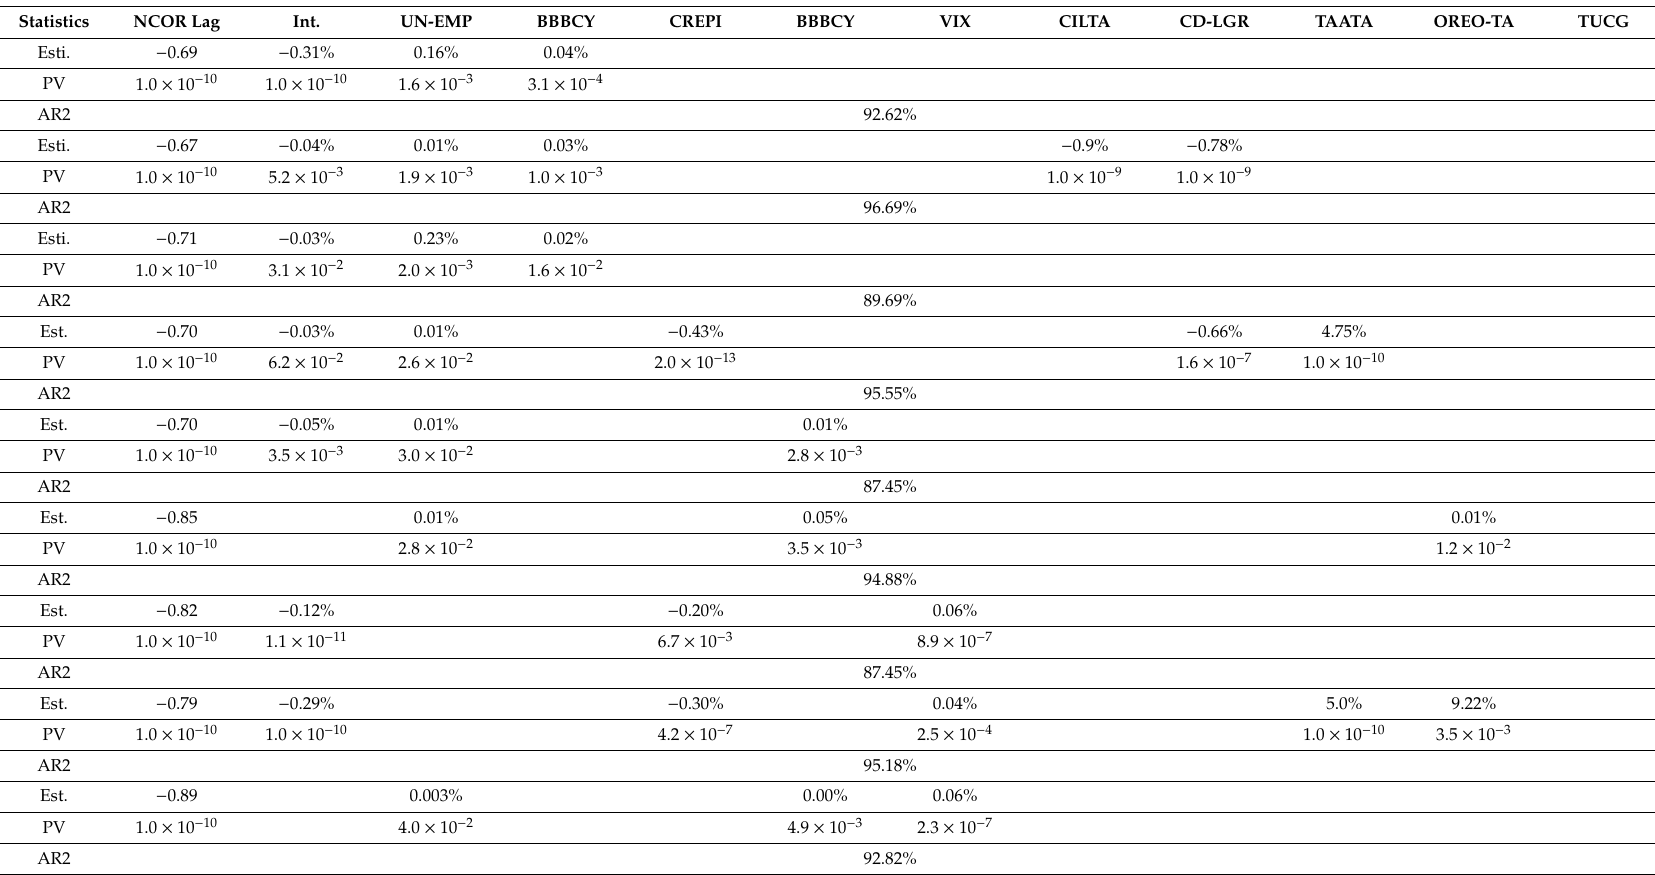
Table 3. Vector autoregressive CECL model estimation results compared—historical Y9 credit loss rates, banking system idiosyncratic, and macroeconomic variables (FDIC SDI Report and Federal Reserve Board